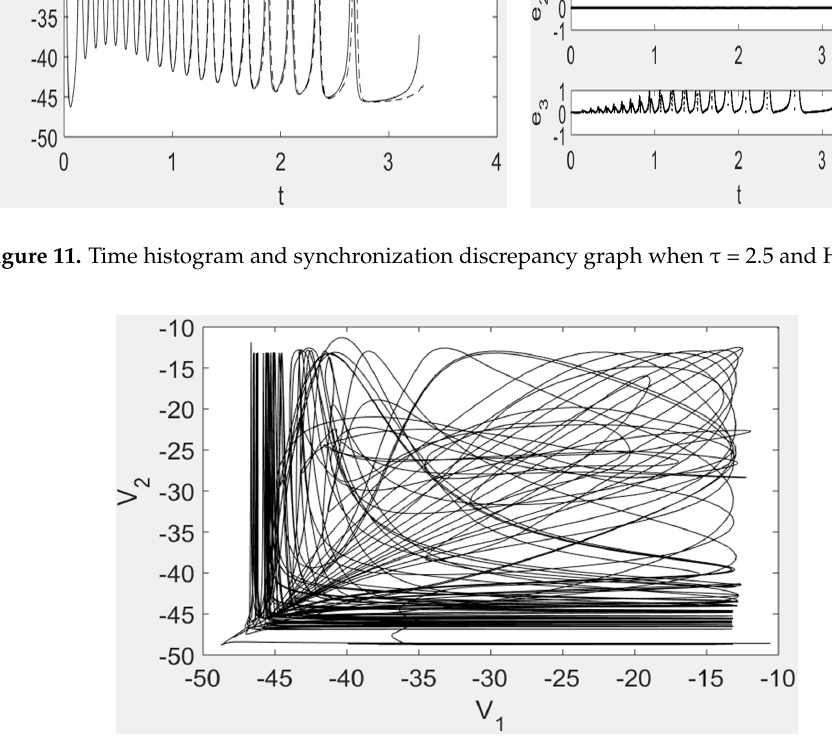
Figure 13. Time histogram and synchronization discrepancy graph when τ = 2.5 and H syn = 5.3. From the above discussion, we conclude that the addition of time lags in the two chemical synaptic- coupled Chay neuron system yields a system change from periodic to chaotic discharge activity, leading to the modification from synchronous to non-synchronized state and destroying the original synchronization state. 5. Conclusions In this paper, the chemical synaptic coupling of a Chay neuron system was studied. The discharge characteristics of the Chay neuron model were analyzed through the state locus, synchronization discrepancy plot, and inter-spike interval bifurcation diagram. The effect of time delay and coupling strength on the coupled Chay neuron system was discussed. The model simulations showed that in a chemical synaptic-coupled Chay neuron system, coupling strength can promote synchronization behavior. Moreover, adding a time delay can inhibit the occurrence of its synchronous behavior, changing from a synchronous to a non-synchronized state. The results have given a deeper insight into the dynamic characteristics of neuron models and provide a basis for further research of neuronal system synchronization.